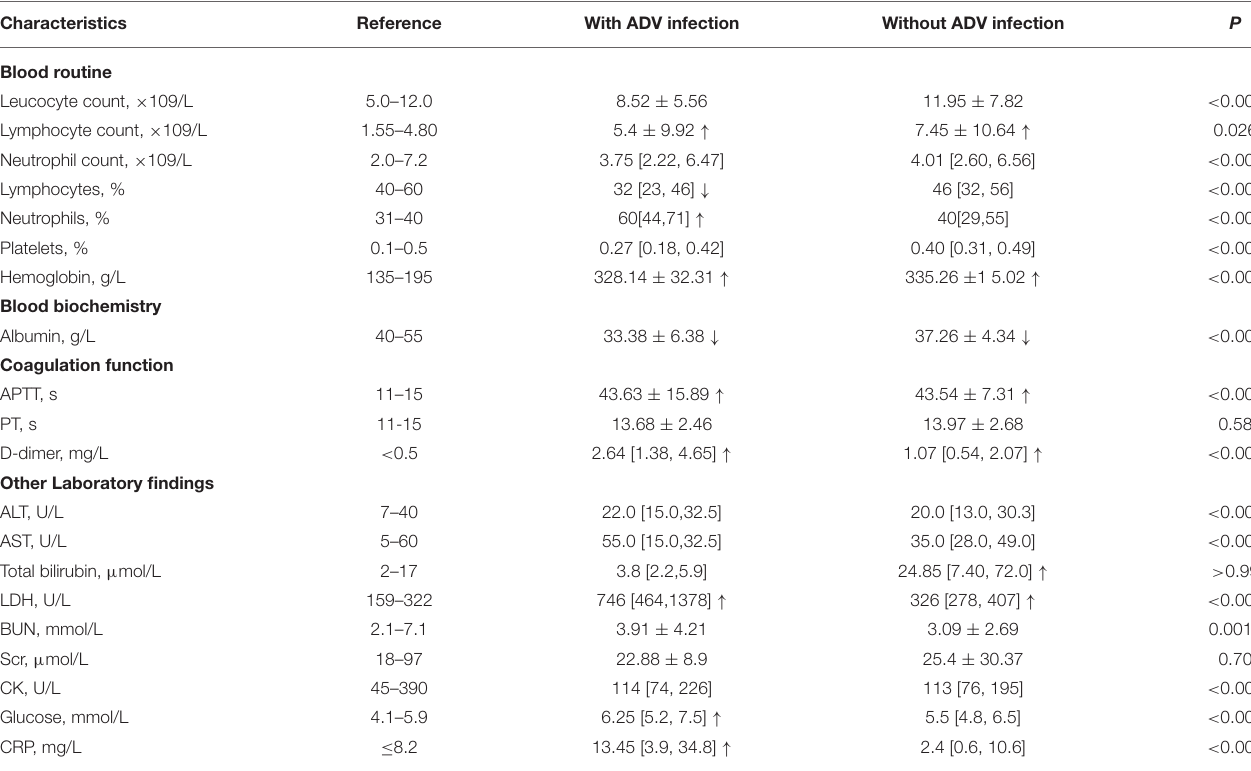
TABLE 2 | Laboratory findings of 1,595 children with severe pneumonia with and without ADV infection.